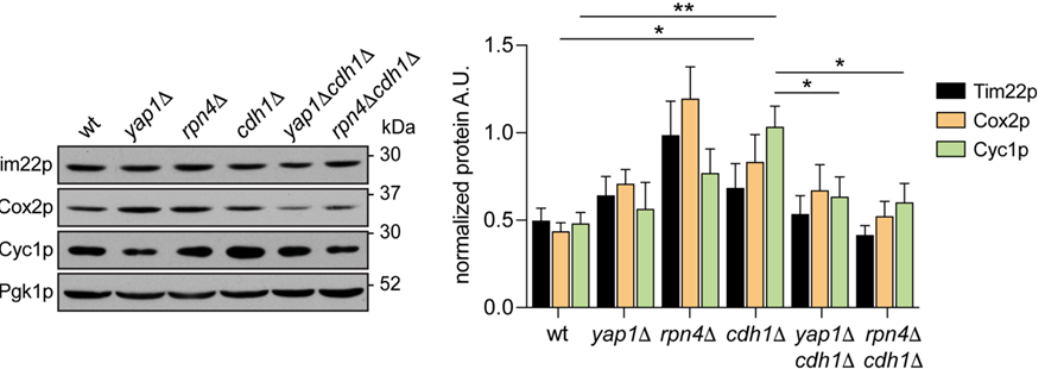
Figure 4. The up-regulation of Cyc1p in the cdh1 ∆ mutant is mediated by the transcription factors Yap1p and Rpn4p. Cells with the indicated genotypes were grown until mid-log phase and Cox2p and Cyc1p levels on total proteins extracts were assessed by immunodetection. Tim22p (inner mitochondrial protein unchanged in cdh1 ∆ cells) is shown as control of mitochondrial mass. A representative blot is shown. Graph represents the relative amount of Tim22p, Cox2p and Cyc1p normalized to Pgk1p. Values are the mean ± SEM ( n = 5); *, p < 0.05; **, p < 0.01; t -test.